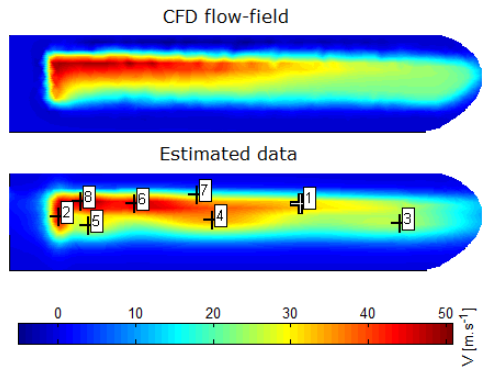
Figure 8. Comparison of the calculated and approximated vertical velocity components, corresponding to the same time instant. A snapshot of the CFD flowfield ( top ) is compared to the approximation using Gaussians ( bottom ). The numbered marks represent the coordinates ( x i , y i ) , i = 1, . . . ,8, as in Equation (1).